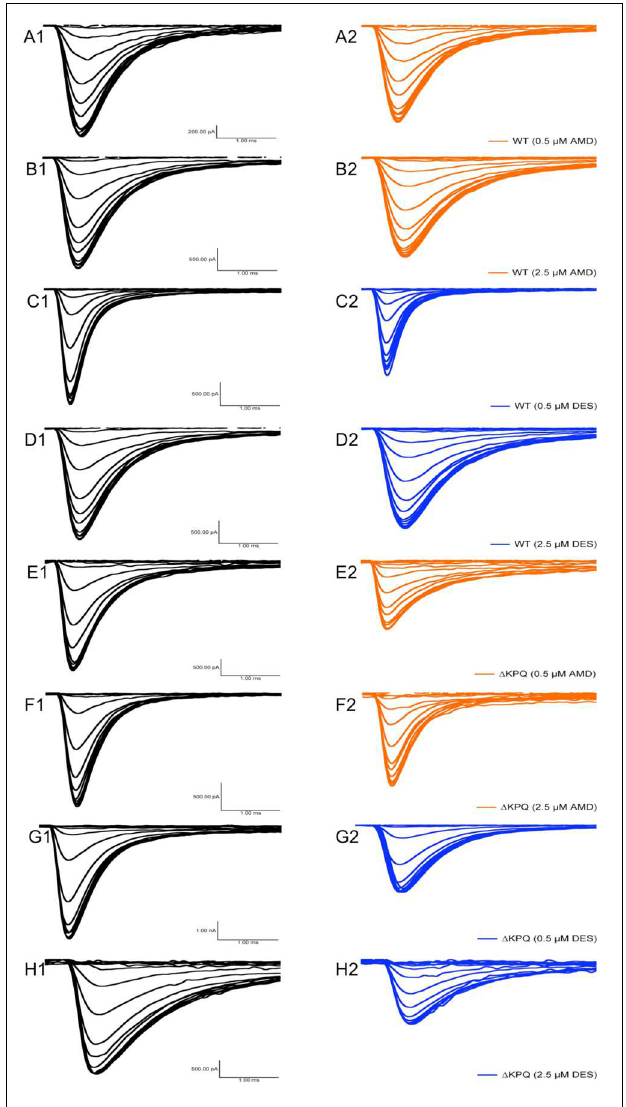
FIGURE 4 | Fast-inactivation traces. Traces show the variation in current levels before and after AMD and DES perfusion.